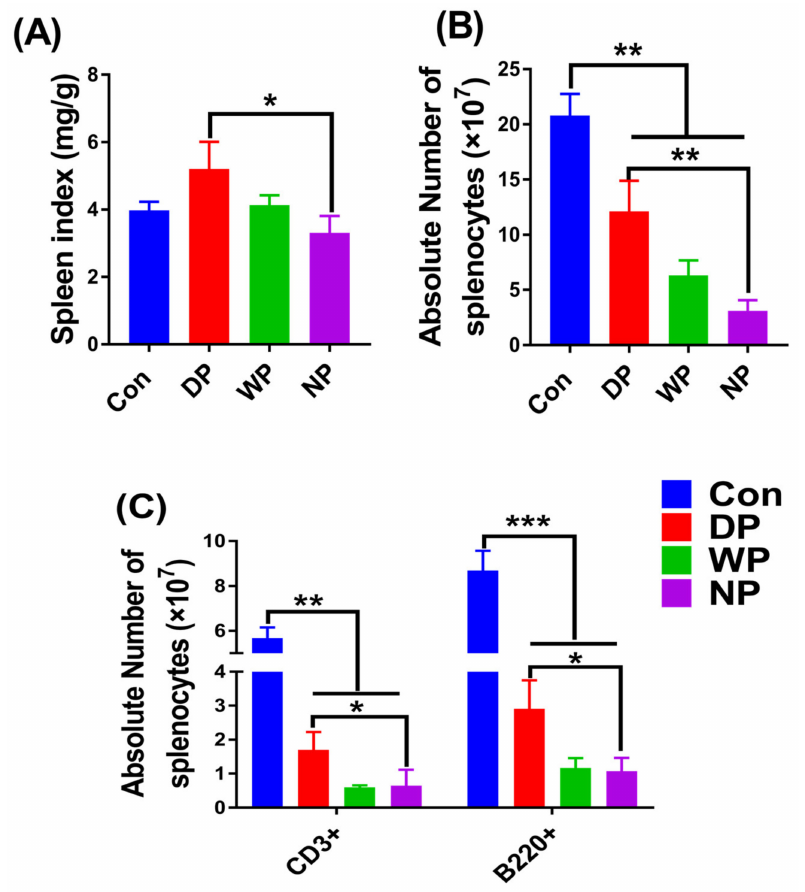
Figure 5. Spleen index, splenocytes, and splenic subsets count were analyzed on day 28 post- BMT. Mice were euthanized and the spleen was removed for the measurement of spleen index ( A ); a single-cell suspension was obtained to measure the number of splenocytes ( B ); splenic subsets were determined by well-defined cell surface markers ( C ). Data are presented as mean ± SEM ( n = 5–7). Results are representative of at least two independent experiments. *** p < 0.001, ** p < 0.01, * p <